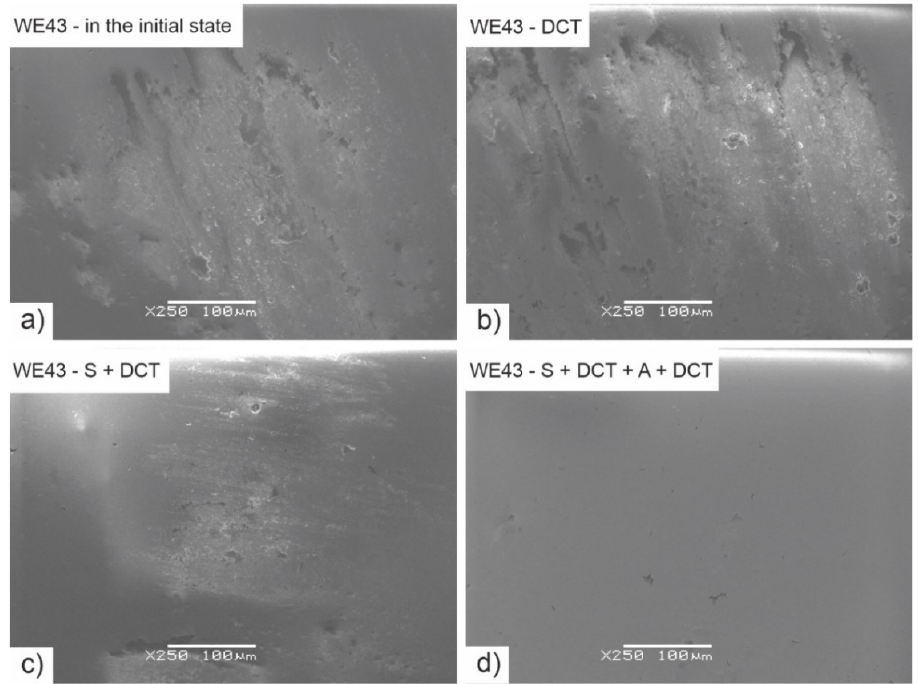
Figure 13. SEM images of ZrO 2 balls after tribological tests in a pair with as-delivered WE43 alloy— ( a ); after deep cryogenic treatment—( b ); after solution treatment combined with DCT—( c ) and after sub-zero treatment combined with precipitation hardening—( d ).